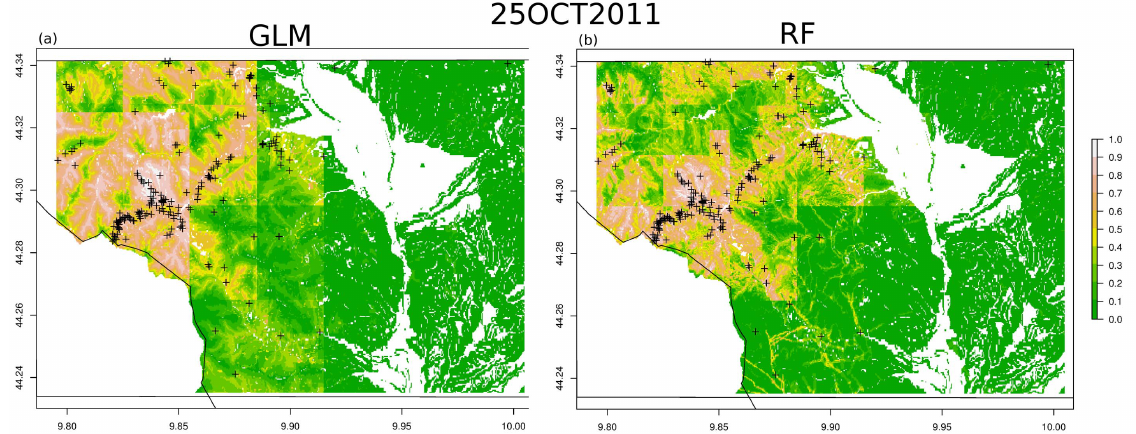
Figure 7. 25OCT2011 landslide hazard maps. Results from the GLM (a) and from the RF classifier (b) . Crosses points are the event inventory maps produced by field surveys a few days after the rainfall event.